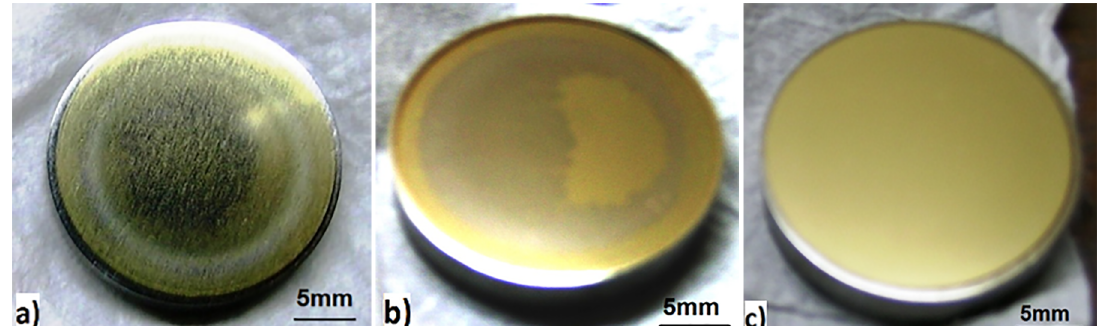
Figure 3. Typical images of the coating surfaces: a) coating completely detached, b) not homogenous coating, c) homogenous coating.